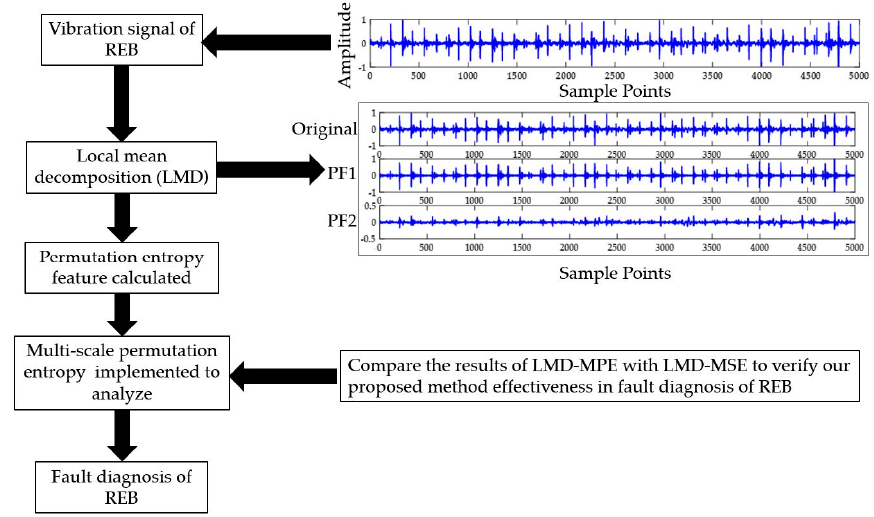
Figure 1. The proposed methodology (LMD-MPE) scheme for REB fault diagnosis.